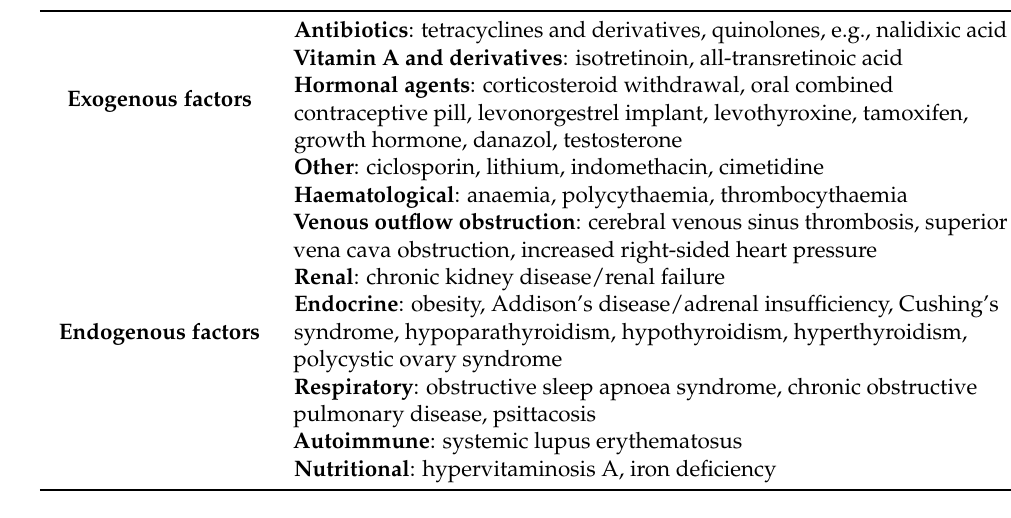
Table 1. Established associations with